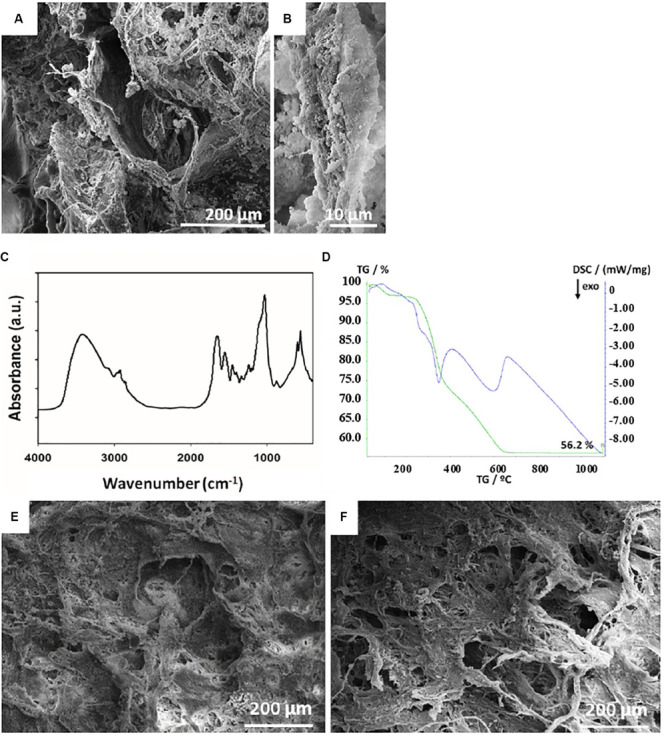
Scaffold architectures. SEM structural characterization of MHA/Coll scaffold (A). The higher magnification micrograph of MHA/Coll (B) shows the collagen fibers with a full mineralization and an amorphous apatite phase. FTIR spectra showing the chemical interaction between the mineral phase and the type I collagen fibers of MHA/Coll (C). Evaluation of the mineral phase on MHA/Coll by TGA-DSC analysis (D). SEM micrographs of MHA/Coll structure evaluated after 21 days under gravity (G, 100×) (E) or microgravity (MG, 100×) conditions (F).